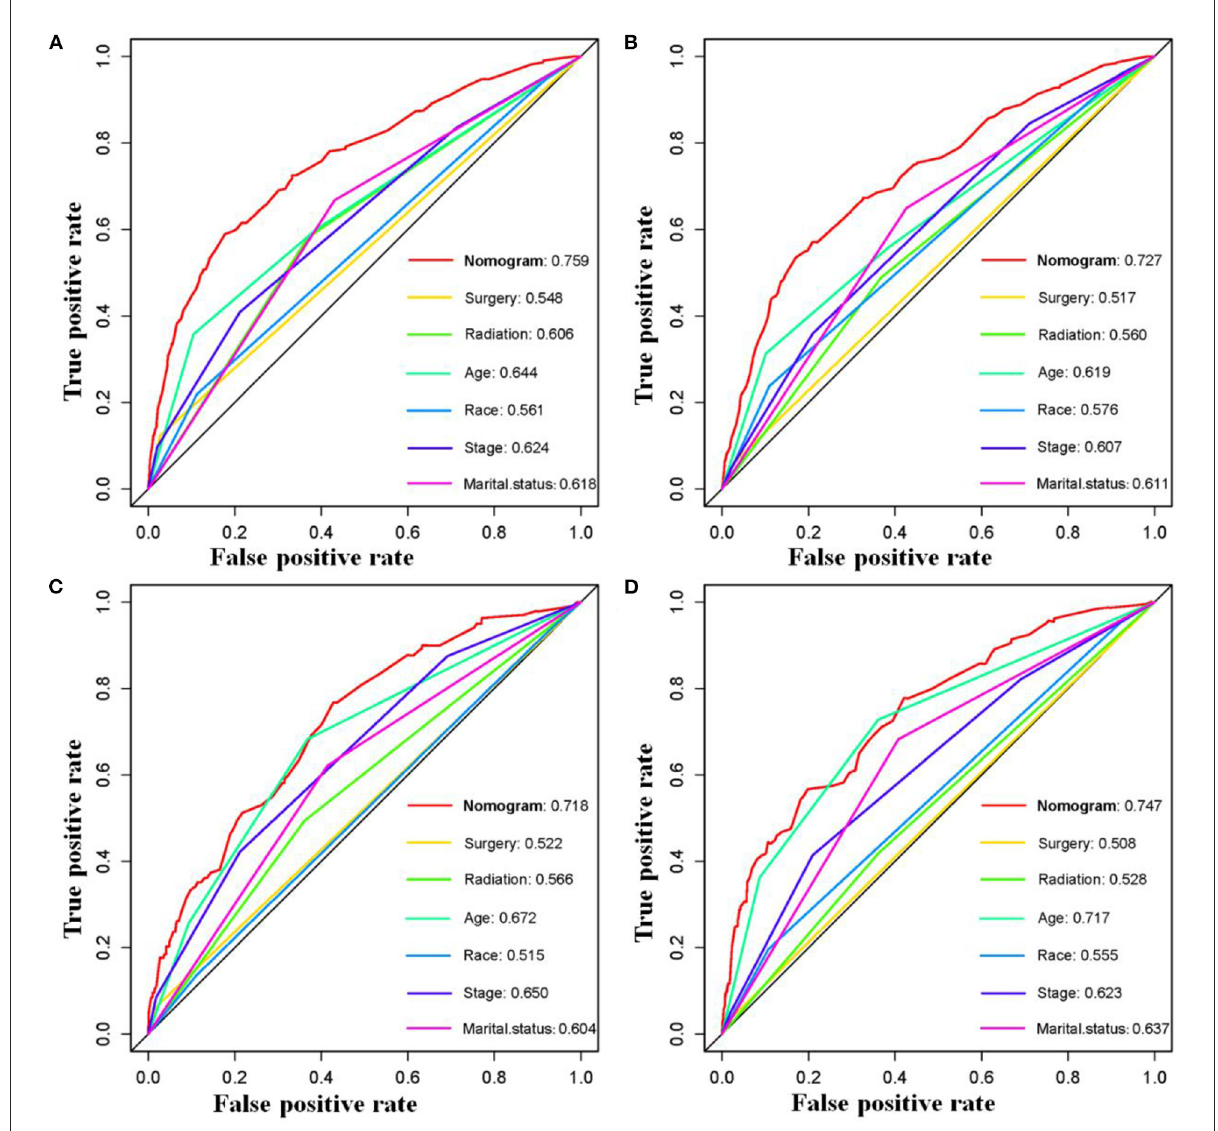
FIGURE5 Comparison of prediction accuracy between the constructed novel nomogram and each HDSS-related independent prognostic factors in older female primary breast cancer patients that underwent chemotherapy at 5- (A) and 8- (B) year in the training cohort and 5- (C) and 8- (D) year in the validation cohort,